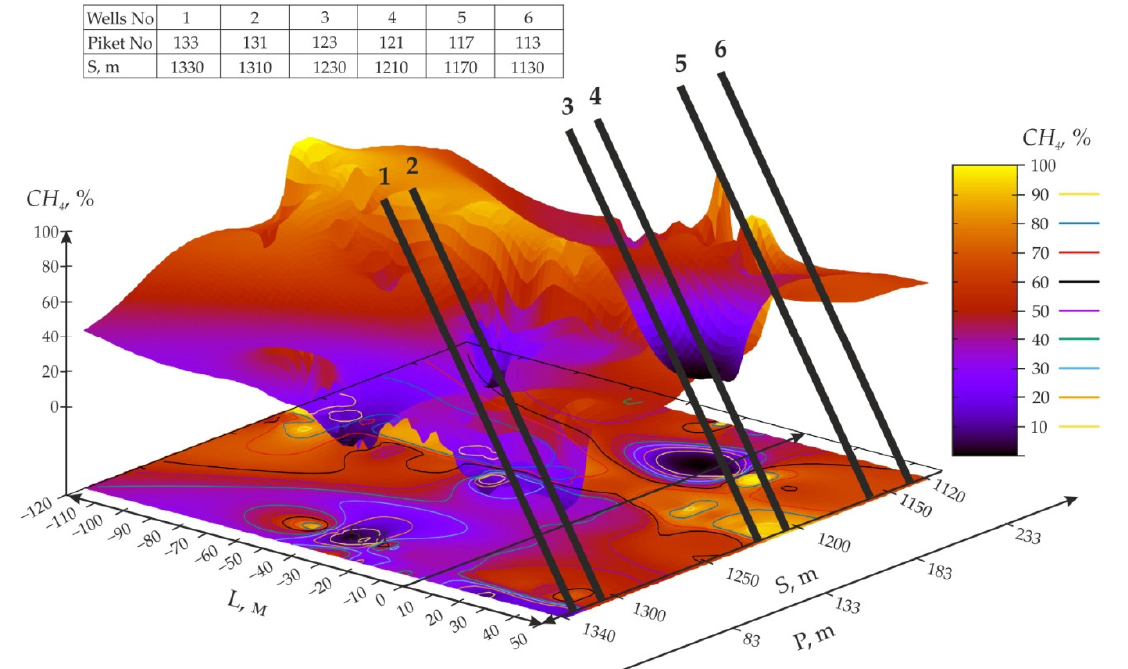
Figure 2. The distribution of methane concentration in the previously mined rock mass during reverse development of the m 3 seam (according to well type No. 2): L is the distance to the stopping face line of the 18th eastern longwall, m; S is remoteness of the face of the 18th eastern longwall relative to the beginning of the extraction column (pickets), m; P is main roof span, at a different